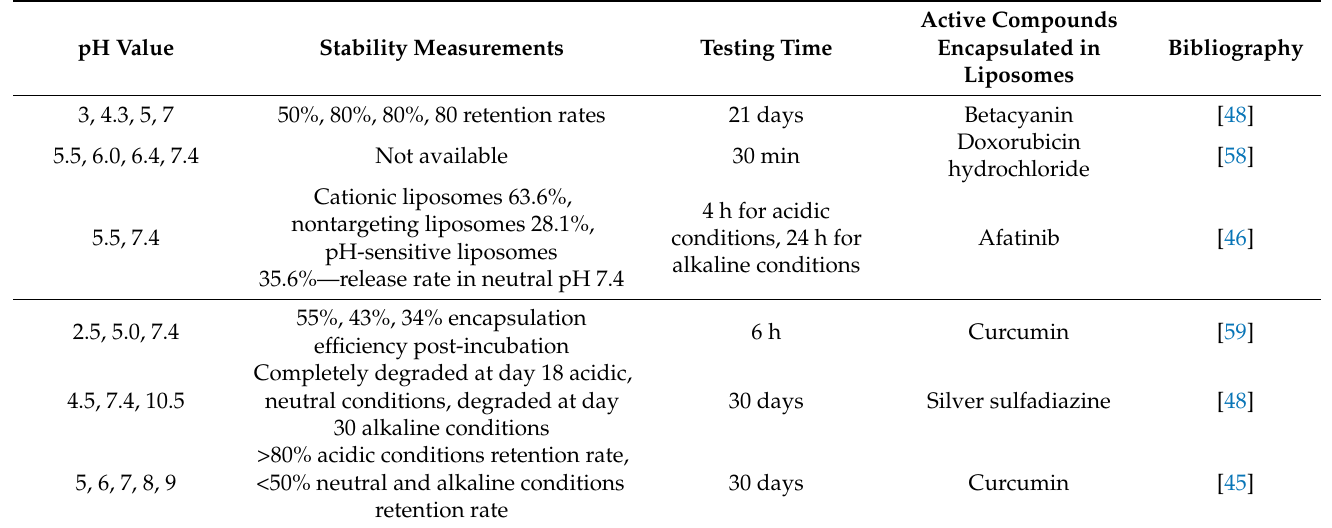
Table 2. Influence of pH on liposome